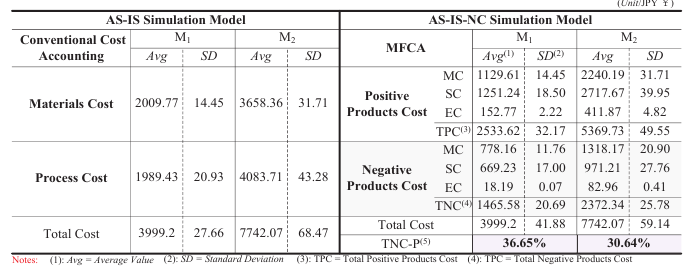
Table 2. Cost results of unit part by comparing the AS-IS-NC model and the AS-IS